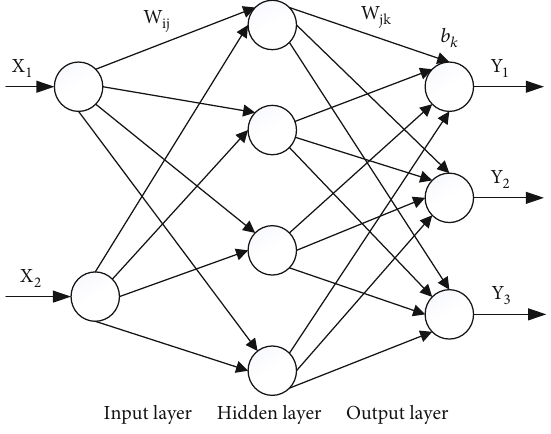
Figure 6: The topological structure of BPANN.